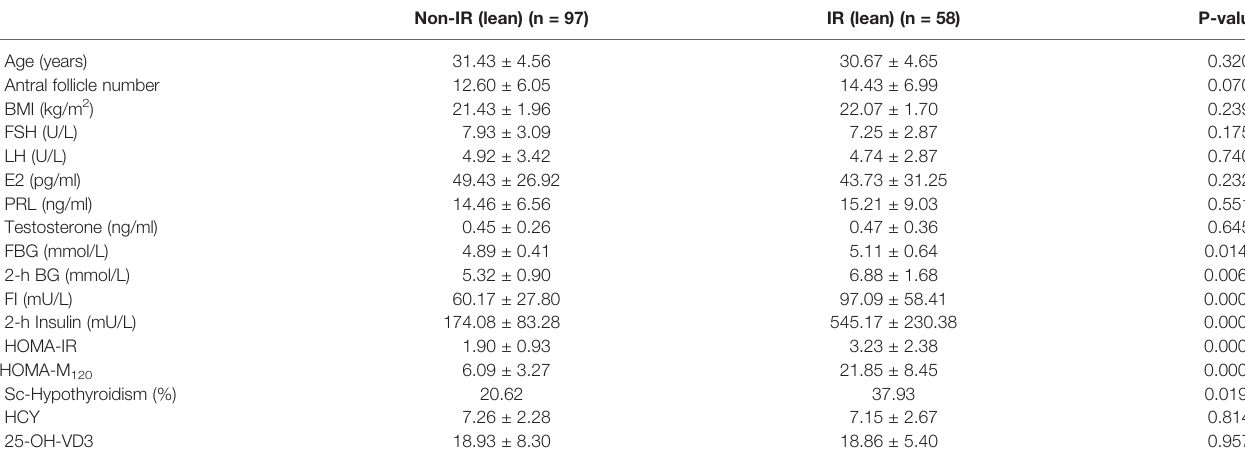
TABLE 1 | Clinical characteristics and endocrine pro fi les of insulin resistant (IR) and non-insulin resistant infertile women (Non-IR).